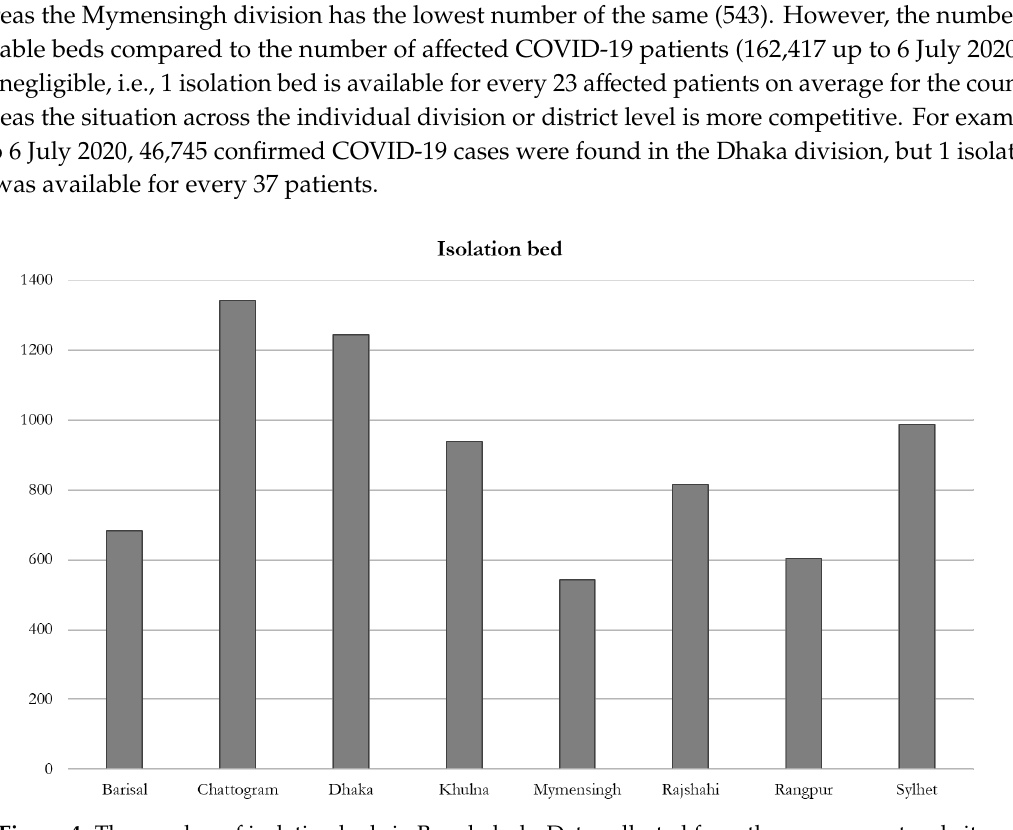
Figure 4. The number of isolation beds in Bangladesh. Data collected from the government websites and field investigation through phone interviews in June 2020.